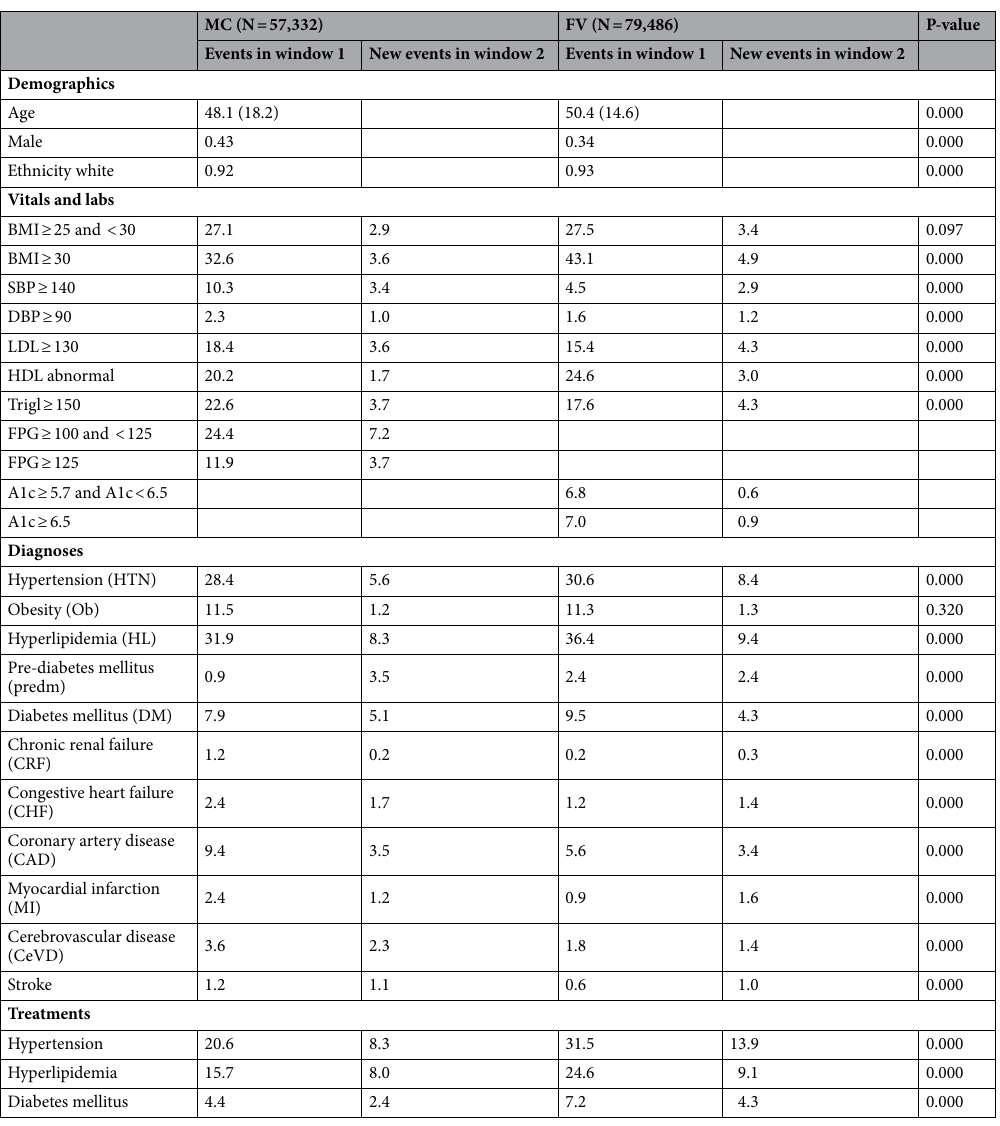
Table 1. Characteristics of the MC and FV data sets. For age, mean (sd) is indicated; for the disease-related events, percentage (%) of positive is indicated. New events rate at the second time windows is reported. BMI: Body mass index; SBP: systolic blood pressure; DBP: diastolic blood pressure, Trigl: triglycerides, FPG: fasting plasma glucose; A1c: hemoglobin A 1c .